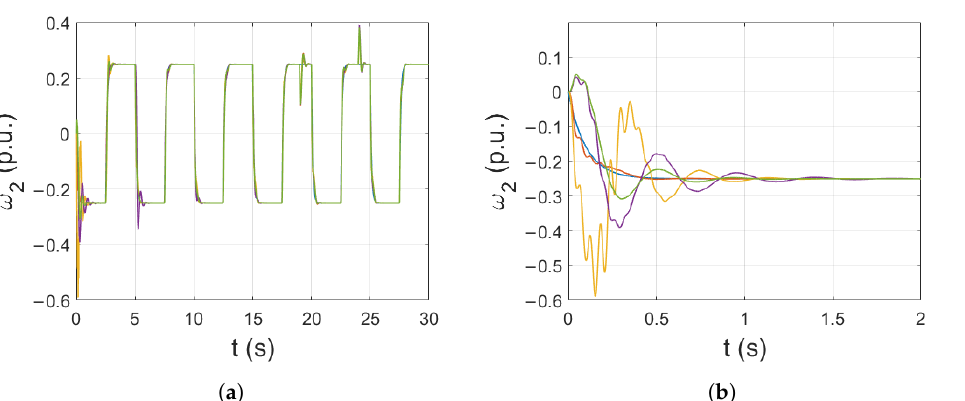
Figure 7. Impact of initial weights randomization: complete simulation ( a ), initial part of the simulations ( b